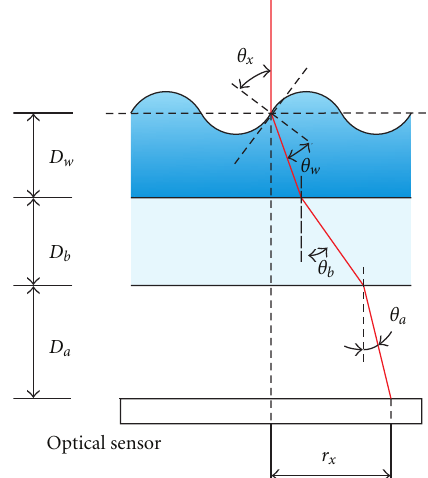
Figure 2: Schematic diagram showing relationship between free surface slope angle and displacement on optical sensor.